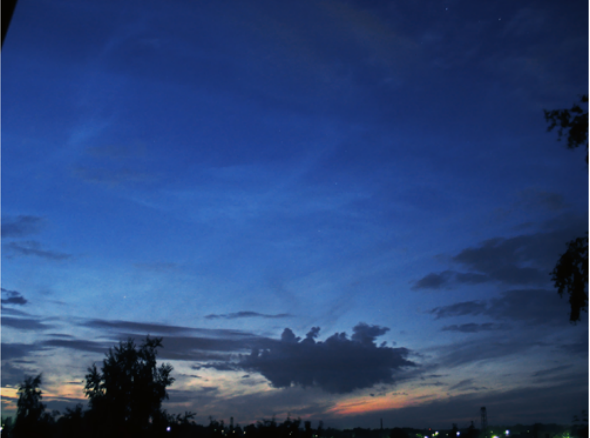
Figure 3. Photographed by P. Dalin. High-altitude cirrus clouds are very similar (by morphological forms, color and brightness) to noctilucent clouds in the morning